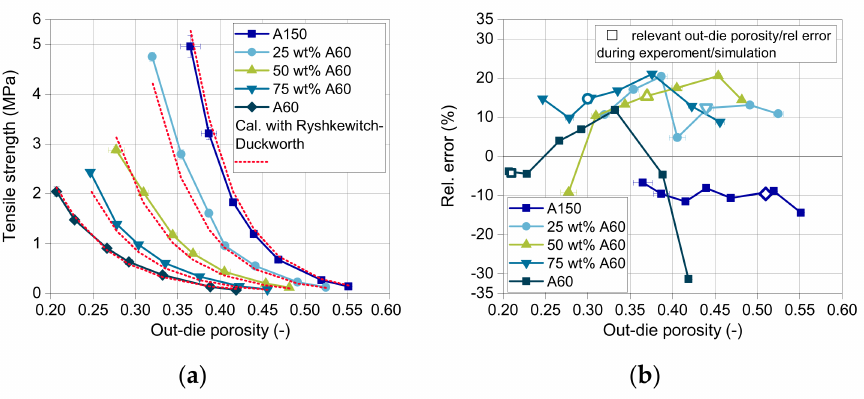
Figure 12. ( a ) Measured (solid lines) and calculated (dotted lines) tensile strength of DI-CAFOS A60, A150, and mixtures, and ( b ) the relative error between the measured and the calculated